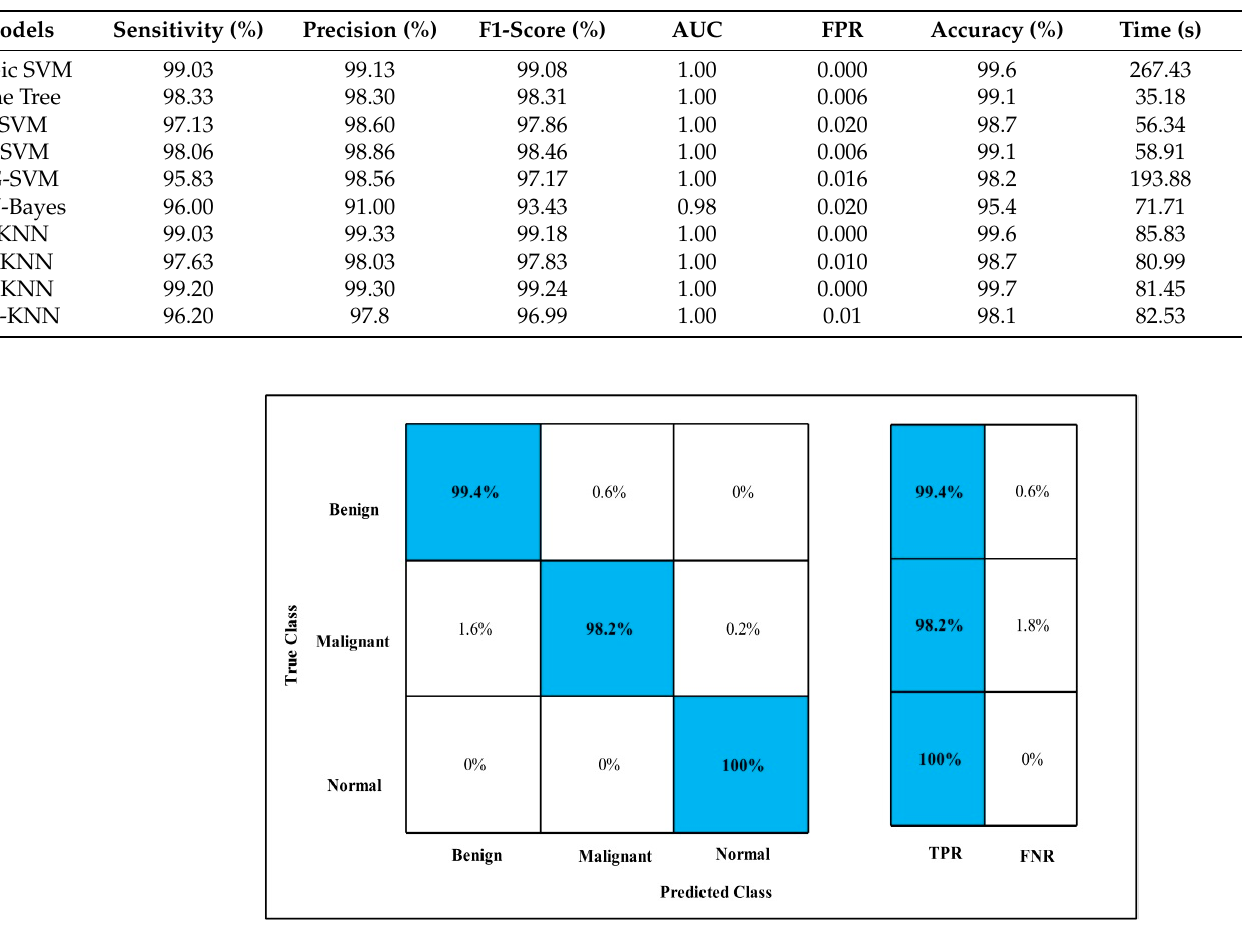
Figure 15. Fine-tuned Nasnet TPR for MIAS.